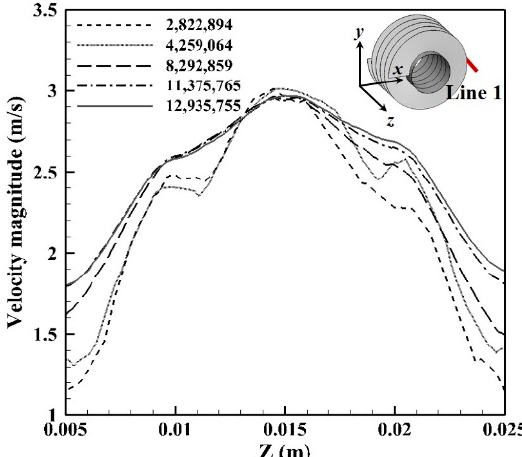
Figure 3. Grid independence test based on velocity magnitude along Line 1, located 2 mm from fin tip in the x ‐ direction.